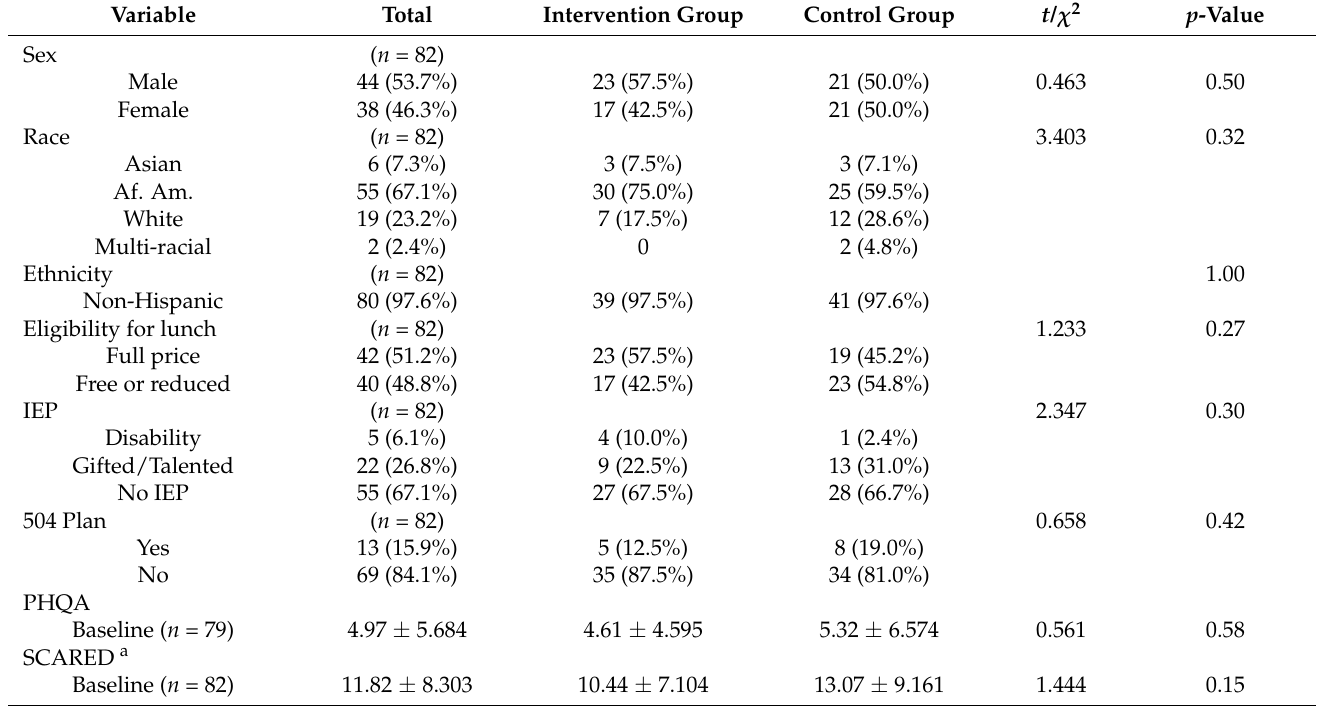
Table 1. Demographics and baseline variables of intervention and control group.